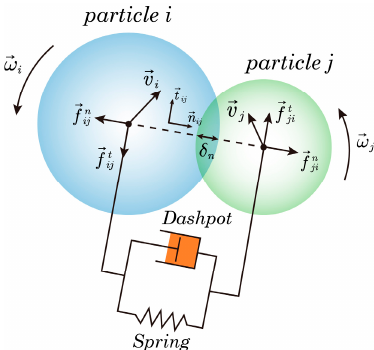
Figure 2. A schematic of spring-dashpot system for the estimation of contact forces. The spring and dashpot are used to model the elastic and viscous forces, respectively.